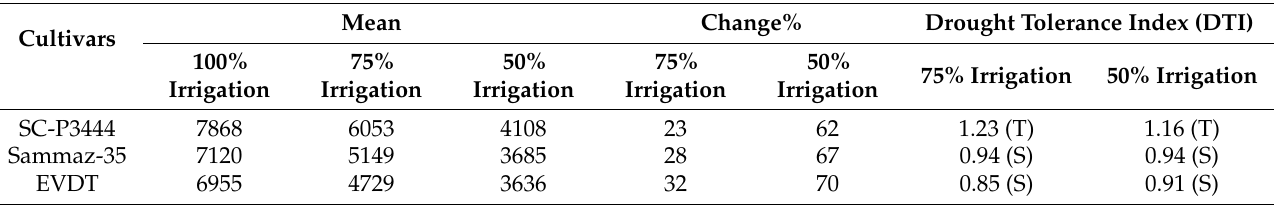
Table 6. Mean grain yield (kg ha − 1 ), change (%) and drought tolerance index (DTI) for maize cultivars under water stress (data are combined across 2018 and 2019